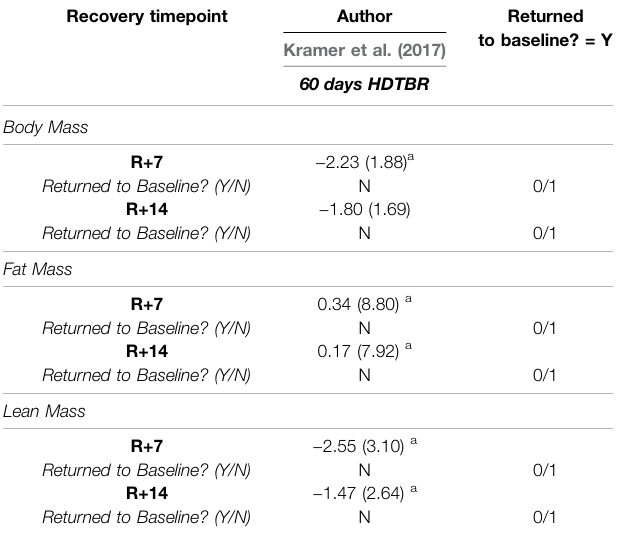
TABLE 3 | % Change with SD of outcome parameters related to ‘ Anthropometric Outcomes ’